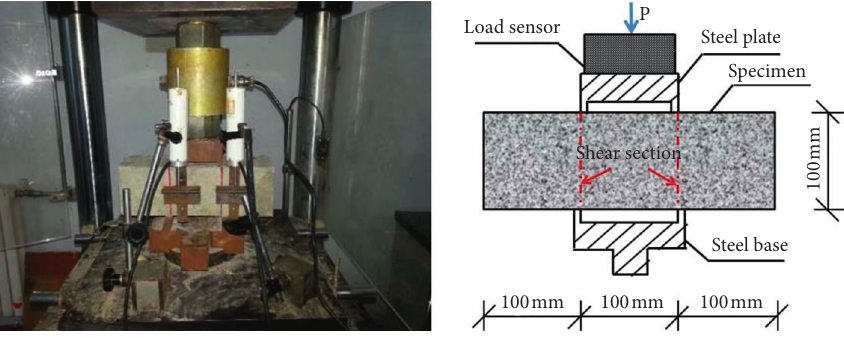
Figure 2: Test setup of shear